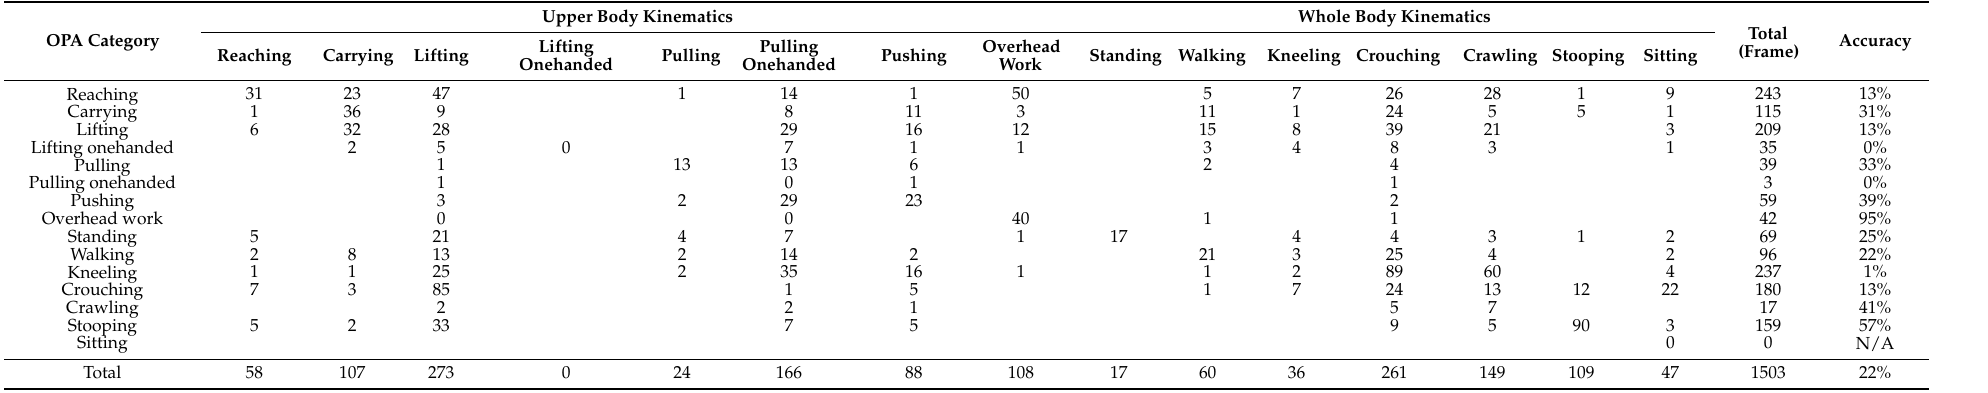
Table 5. Accuracy of the top OPA prediction during simulated work tasks. The confusion matrix shows the CNN model accuracy of OPA predictions in simulated work tasks. OPAs were classified as upper body kinematics or whole-body kinematics. Cells in the left-hand column represent OPA categories in tasks and cells in the second row represent CNN predicted activities. Cells on the main diagonal and off-diagonal indicate the number of correct and incorrect predictions of each activity. The two right-hand columns represent the total frame and prediction accuracy of each OPAs, respectively. The cell at the bottom-right corner indicates the average prediction